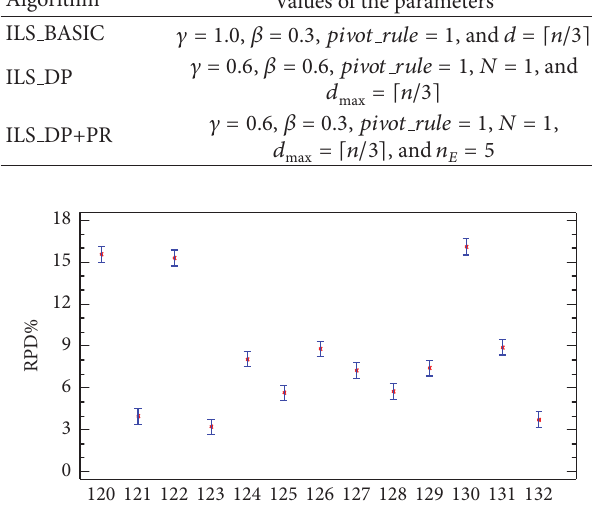
Table 3: Parameters setting. Algorithm